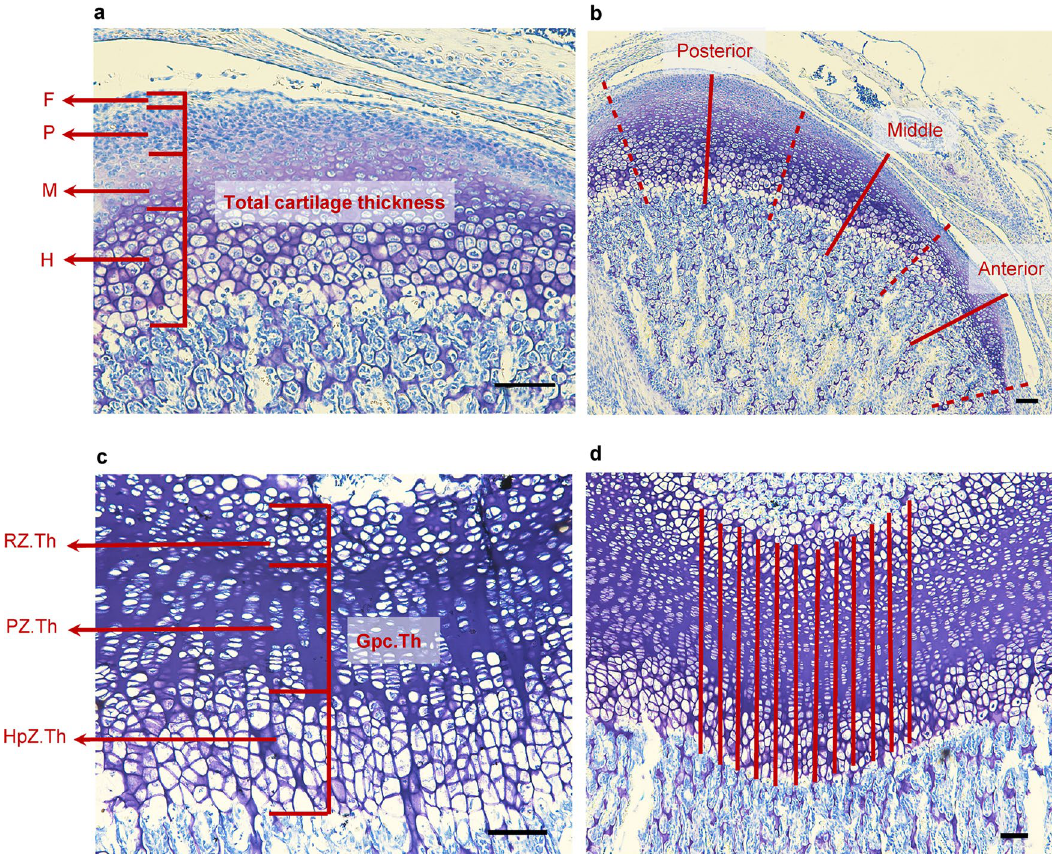
Figure 4. Histological images of mandibular condylar cartilage and tibial growth plate from a 2-week-old rat following toluidine blue staining. ( a ) Sagittal section of mandibular condylar cartilage. Black dashed lines show the divided region of condyle, including the fibrous layer (F), proliferating layer (P), maturative layer (M), and hypertrophic layer (H). Red lines in ( b ) show the center of each part used to measure thickness of mandibular cartilage. ( c ) Longitudinal section of tibial cartilage, including the resting zone (RZ.Th), proliferative zone (PZ. Th), hypertrophic zone (HpZ.Th), and height of growth plate (Gpc.Th). ( d ) Twelve parallel lines drawn through tibial cartilage to permit measurements. Scale bar = 100